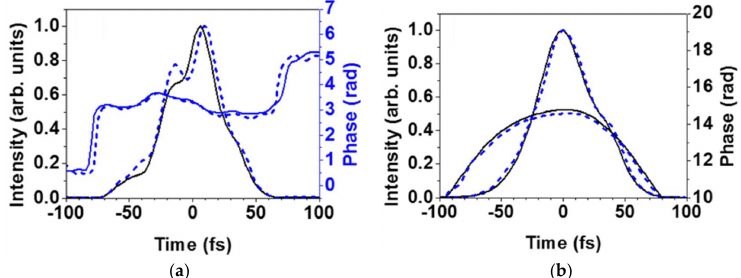
Figure 8. The two sets of retrieved temporal intensities (solid line) and phase (broken line) profiles of ( a ) pulse A and ( b ) pulse B retreived from the two XFROG